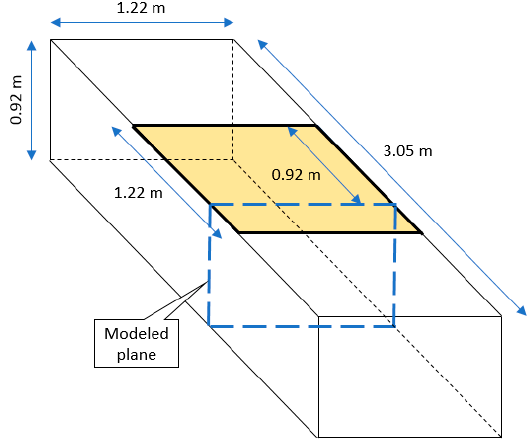
Figure 2. Schematic of a soil pit showing the location and orientation of the plane modeled in HYDRUS-2D. The yellow square depicts the opening in the sidewalk for the tree while the blue dashed line depicts the modeled plane.